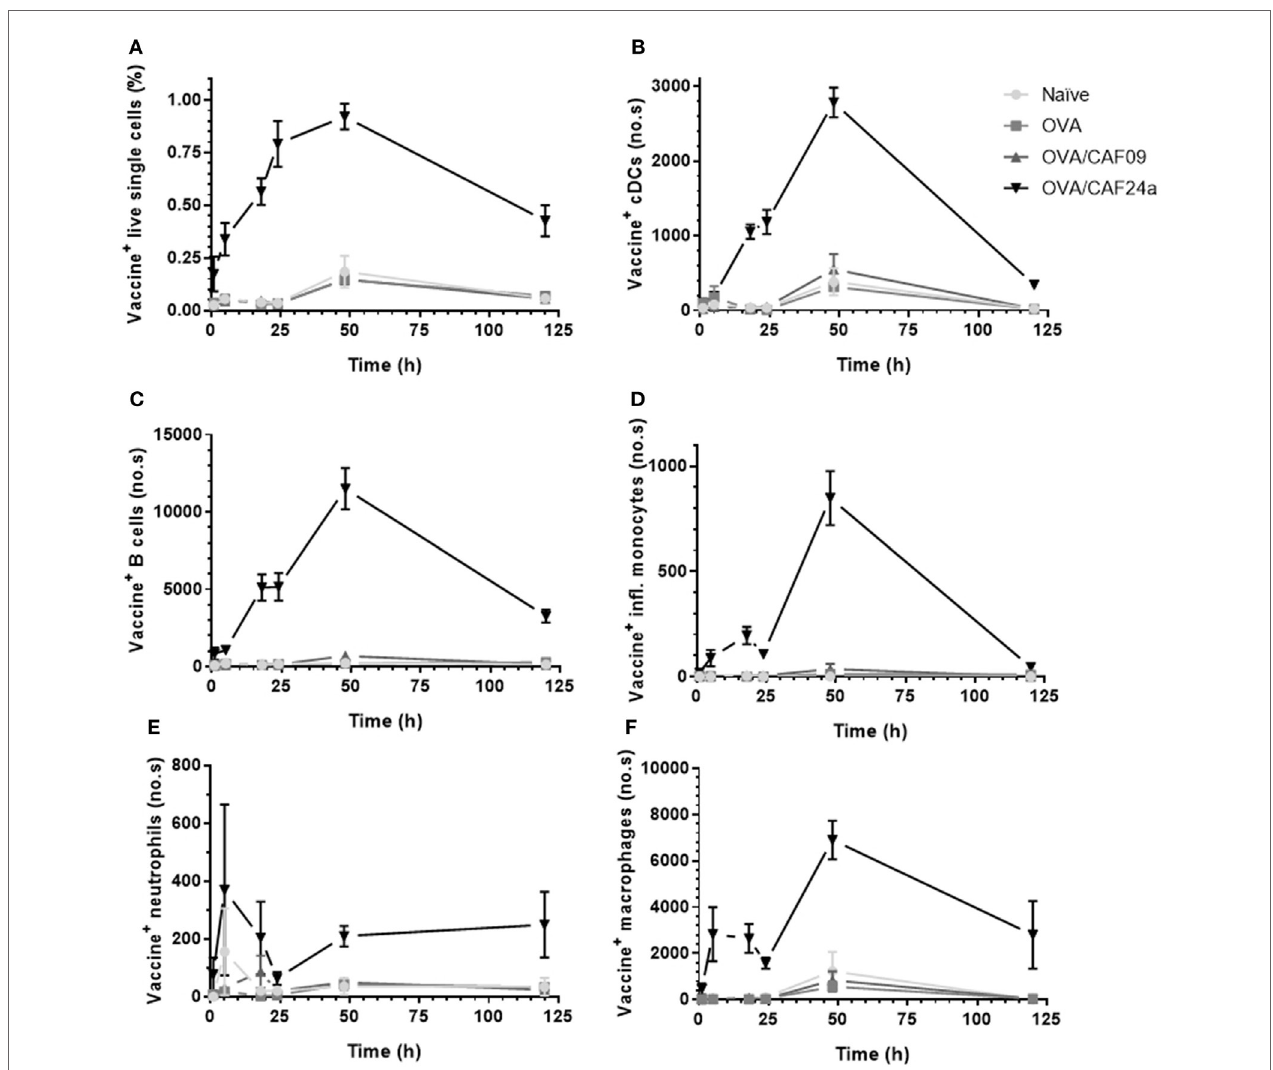
FigUre 3 | (a) Fraction of vaccine + (adjuvant + , antigen − / + ) lymphocytes, and number of (b) vaccine + cDCs (CD11b + , CD11c + , MHC-II + ), (c) vaccine + B cells (CD19 + ), (D) vaccine + inflammatory monocytes (CD11b + , Ly6C + ), (e) vaccine + neutrophils (Ly6G + ), and (F) vaccine + macrophages (CD11b + , F4/80 + ) in the draining lymph nodes following intramuscular immunization with ovalbumin (OVA) adjuvanted with cationic adjuvant formulation (CAF)09 and CAF24a, respectively, as compared to naïve mice and mice immunized with unadjuvanted OVA. n = 2 (naïve, unadjuvanted OVA) and n = 6 (OVA/CAF24a and OVA/CAF09), data points represent mean ±